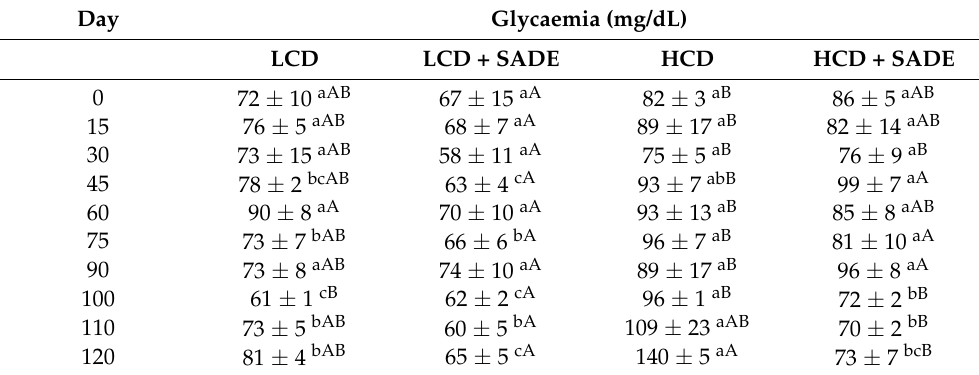
Table 3. Effect of SADE on glycemia (mg/dL) variation in P. obesus